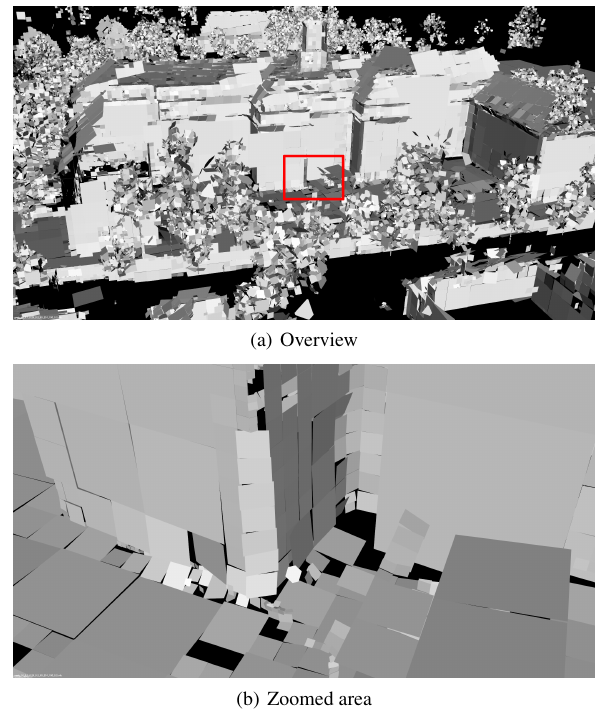
Figure 5. Polygon model generated with the default parameter settings. The content of the area marked in Figure (a) is shown zoomed in by Figure